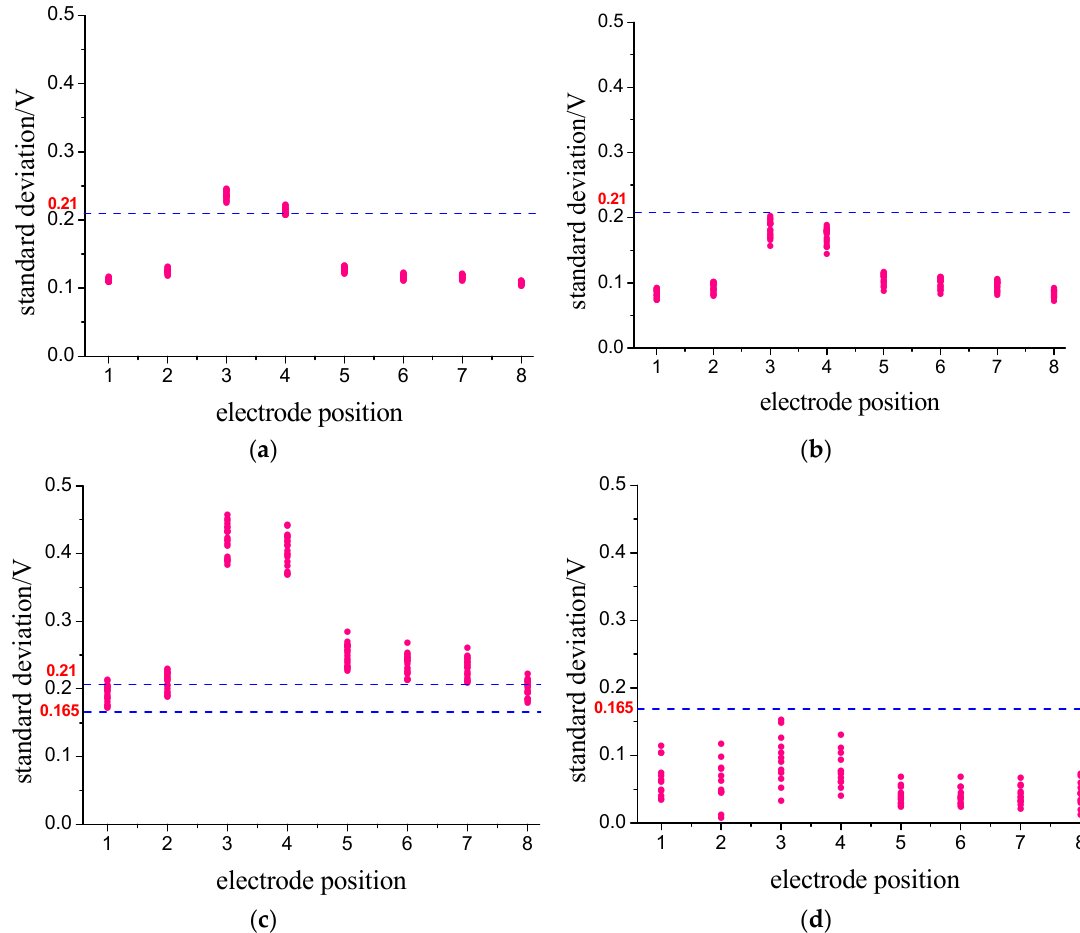
Figure 12. Regions of the four patterns using the standard deviation. ( a ) fully suspended flow; ( b ) stratified flow; ( c ) dune flow; ( d ) slug flow.